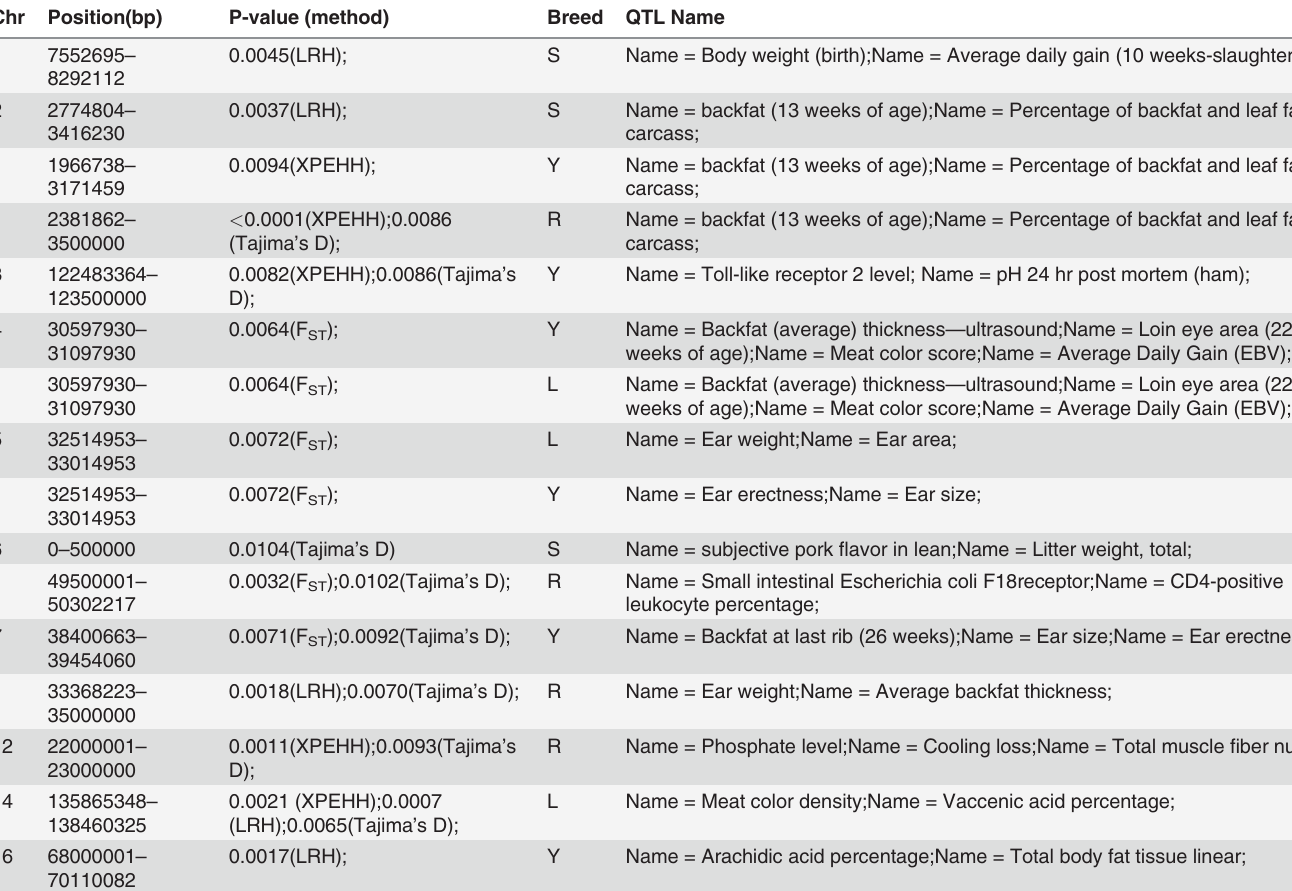
1 Complete QTL list see S1 Table and the signi fi cance level for genome-wide P-values of each method was based on the standard False Discovery Rate